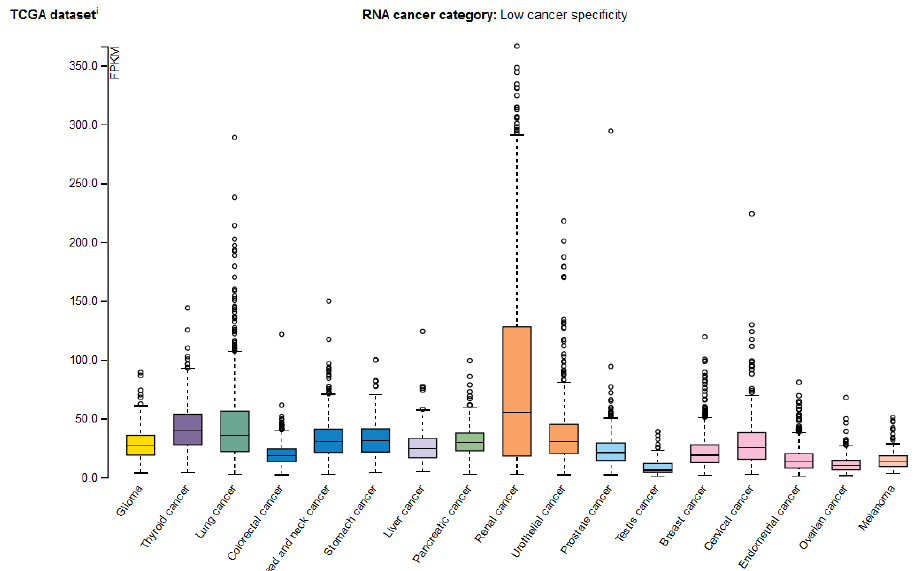
Figure 6. The EPAS1 mRNA expression profiles in various cancer types from the Human Protein Atlas. The RNA-seq data is presented as a median number of fragments per kilobase of exon per million reads (FPKM) for 17 cancer types and is generated by The Cancer Genome Atlas (TCGA). Somatic variants in the EPAS1 nucleotide sequence were detected in various